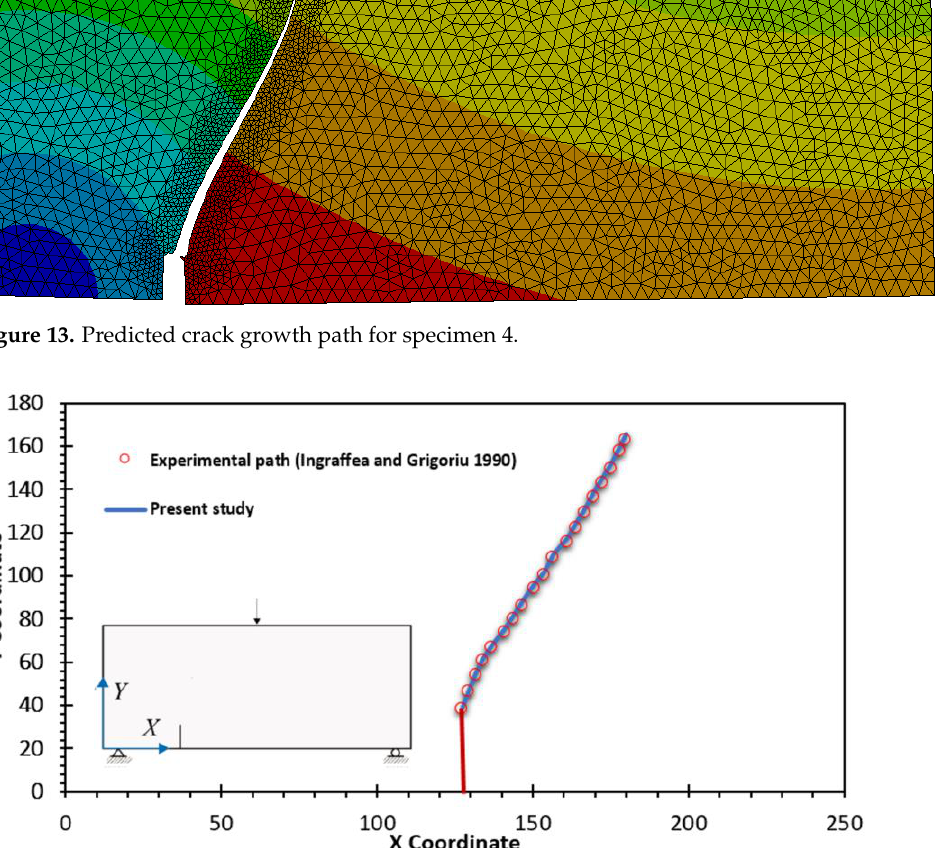
Figure 14. Crack tip coordinates comparison for specimen 4.